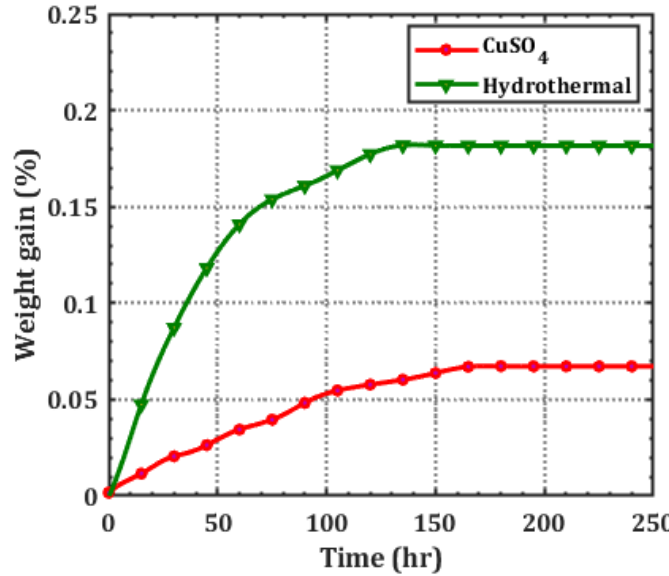
Figure 3. Variation in % weight gain of XLPE specimen due to aging.